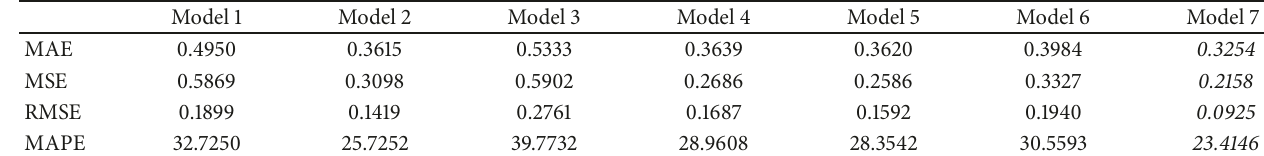
Table 5: MAE, RMSE, and MAPE (%) of predicting the incidence of influenza.